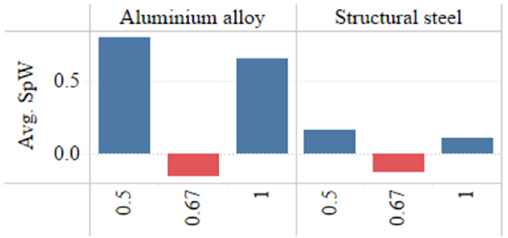
Figure 10. Effect of having an ice stringer vs. no ice stringer on the SSF of a metal